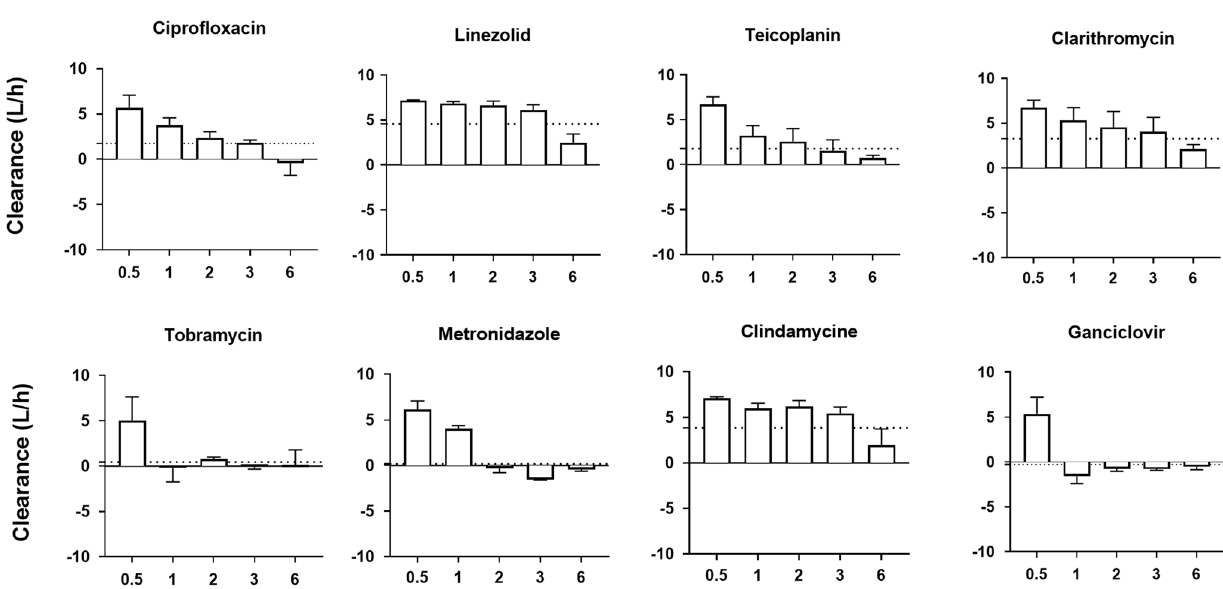
Figure 5. Kinetics of adsorber clearance of other anti-infective agents. Bars represent instantaneous clearance at the different study time points: 30 min (0.5 h), 1, 2 and 3 h after therapy initiation as well as the last measure obtained (6 h). Dotted lines represent total clearance (also represented in Fig. 2). Reported values are mean and standard